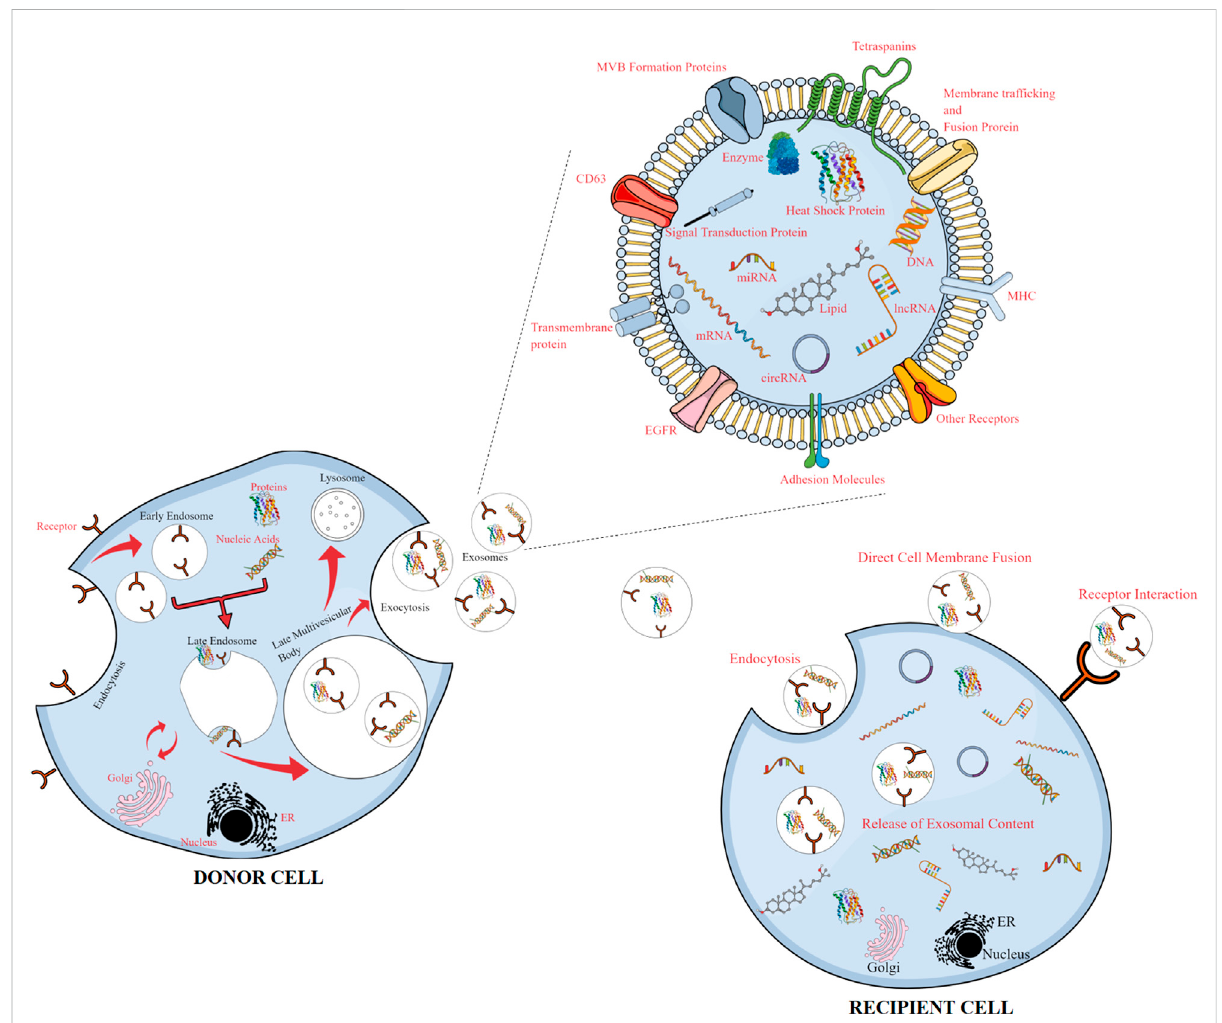
FIGURE 2 Release of exosomes from donor cells and uptake by recipient cells, with an enlarged view of the exosomal content. Exosomes released from donor cells carry cargos of proteins, lipids, and genetic materials and can be taken up by recipient cells, reprogramming the recipient cells upon transfer of their bioactive